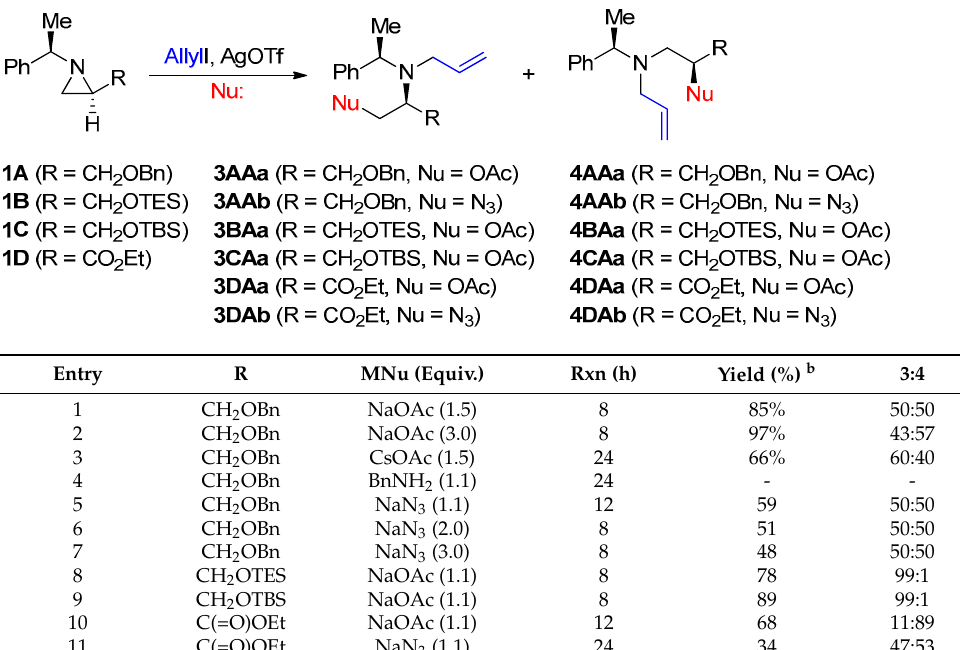
Table 2. Allylative aziridine ring-opening reactions with ICH 2 CHCH 2 (1.25 equiv.) and AgOTf (1.05 equiv.) in CH 3 CN a